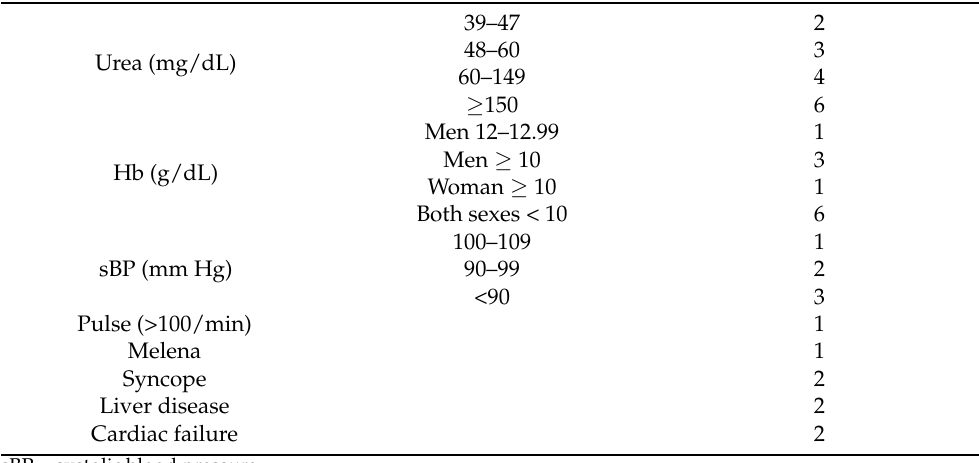
Table 2. Glasgow-Blatchford score [7].